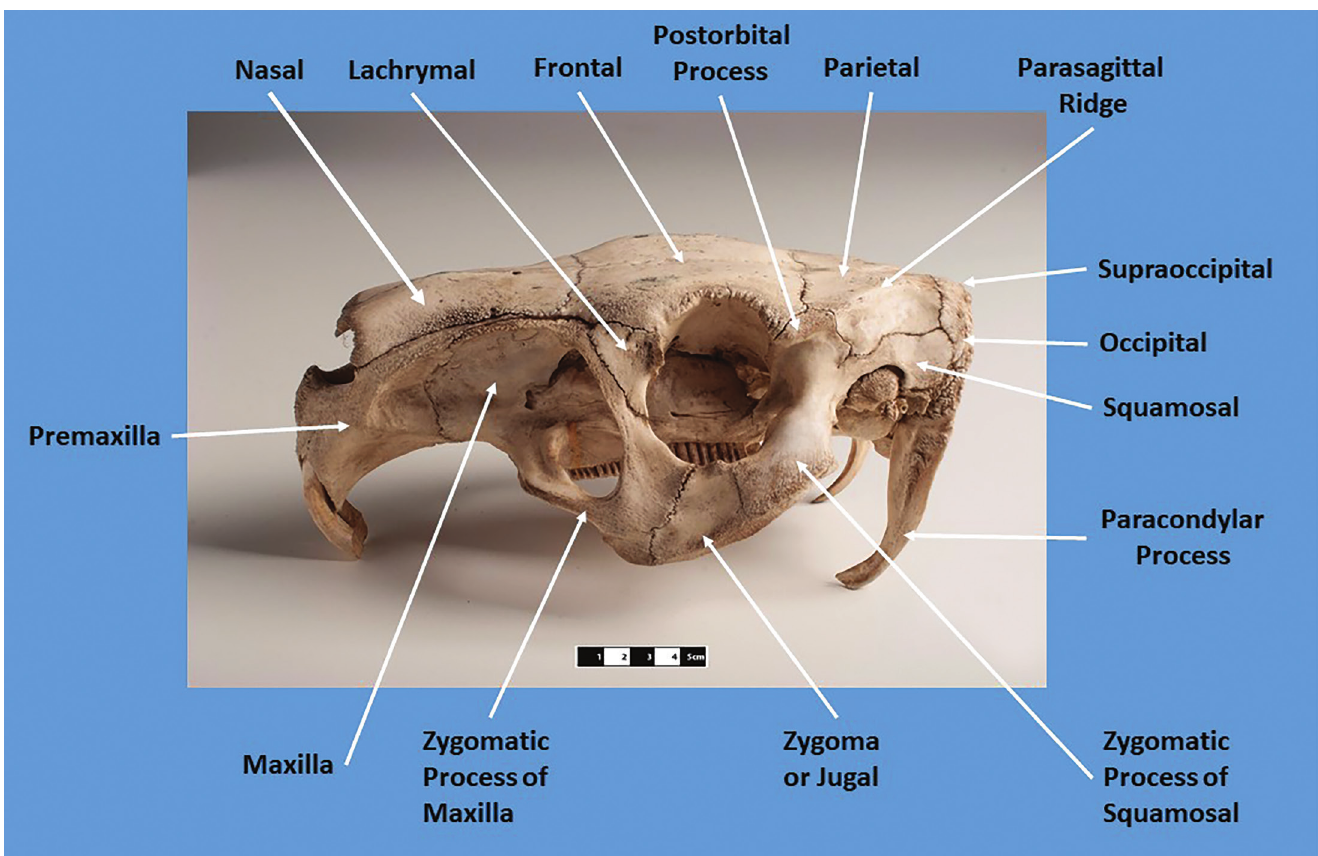
Figure 1. Cranial terminology utilized in this paper. Museum of Veterinary Anatomy FMVZ USP / Wagner Souza e Silva